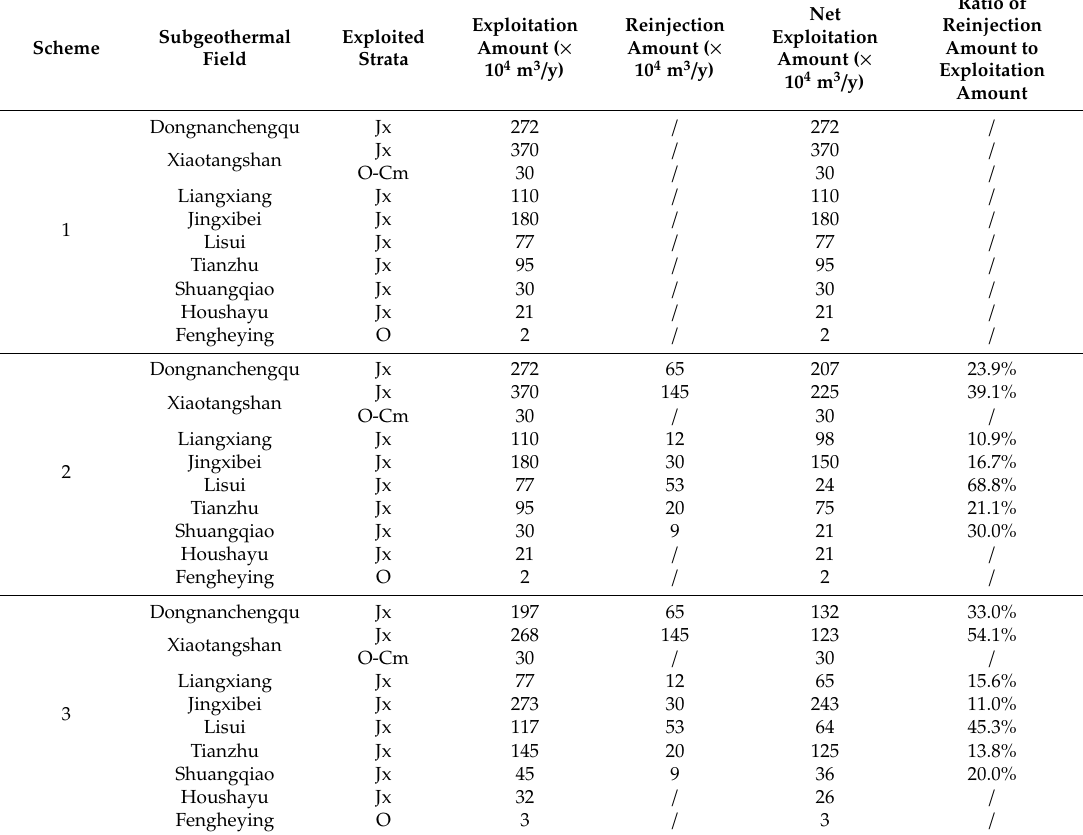
Table 9. Exploitation and reinjection amount under di ff erent schemes in the predicted period.